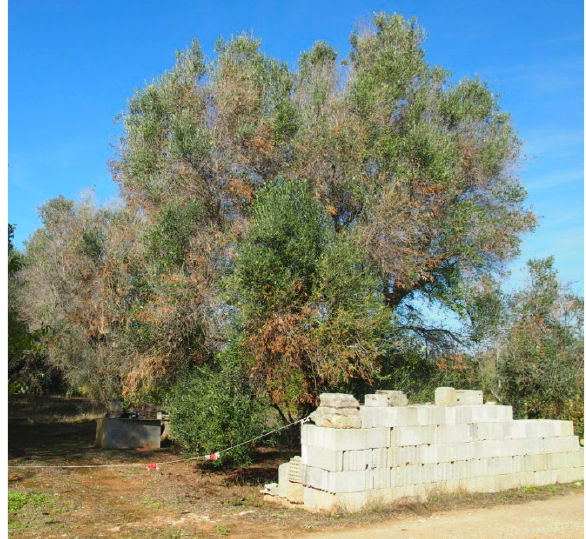
Figure 1. Decline of the canopy of an olive tree infected by Xylella fastidiosa